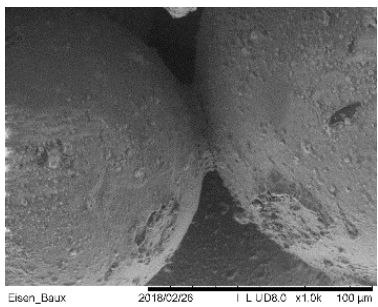
Figure 4. SEM-Micrograph of the connection between two grains.